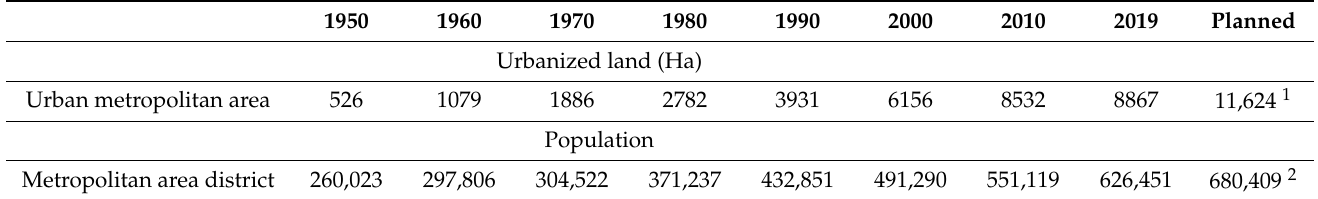
Figure 3. Metropolitan area of the so-called “orchard of Murcia” ( up ) and the main urban area of the city ( bottom ). Source: Sentinel 2 satellite. Table 1. Evolution of the urban metropolitan area of Murcia area in terms of urbanized land and population from 1950 to 2019.